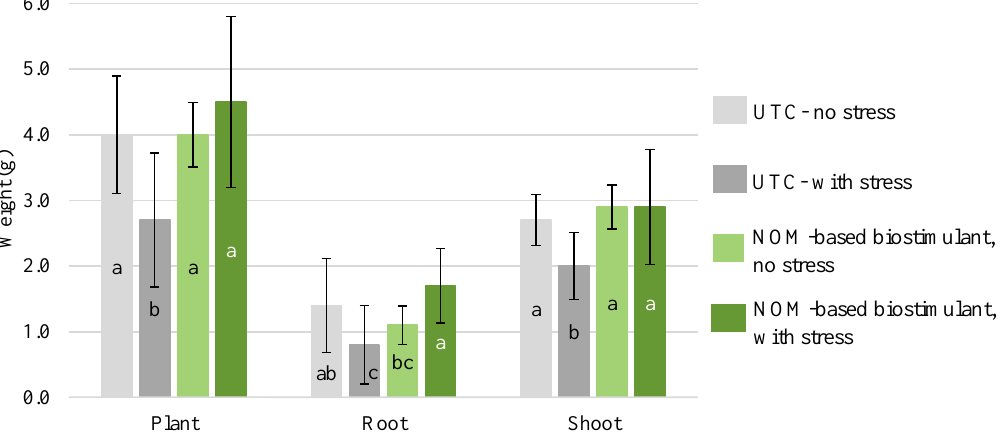
Figure 3. Average plant, root, and shoot weights 10 days after foliar applications during the salt stress tomato nursery trial for the untreated check (UTC) non-stressed plants, UTC stressed plants, NOM-based biostimulant treated non-stressed plants, and NOM-based biostimulant treated stressed plants. Means with the same letter designation centered on each bar do not differ significantly ( p = 0.10, least significant difference), and error bars represent one standard deviation. See also Supplementary Table S3, where ANOVA p values are reported.